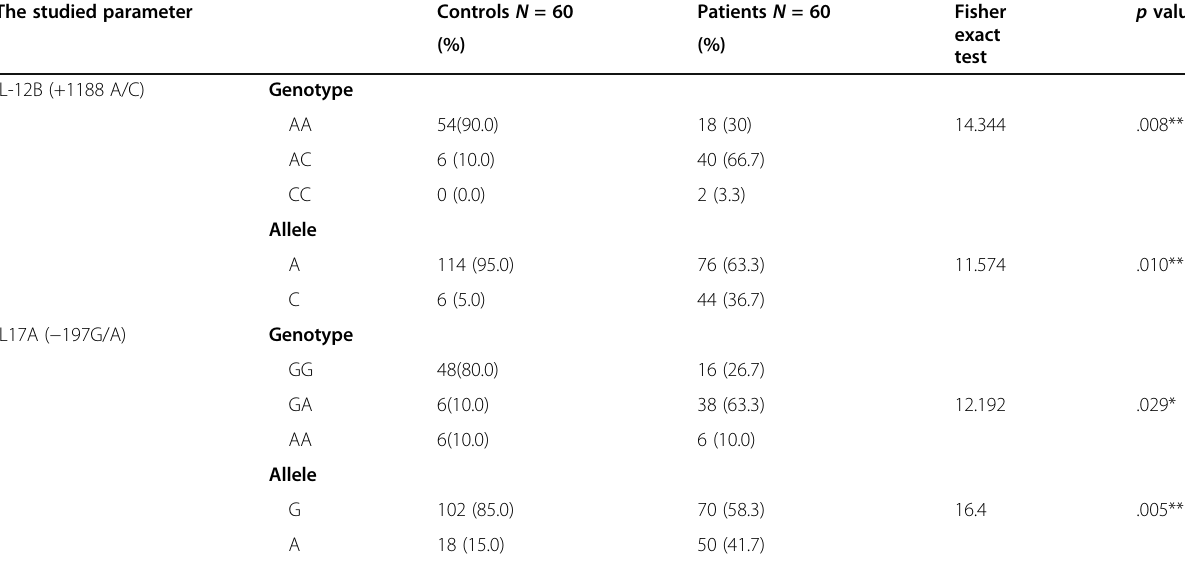
Table 6 Genotype and allele frequencies of IL12B (1188 A/C) and IL17A ( − 197G/A) polymorphisms in patients and controls The studied